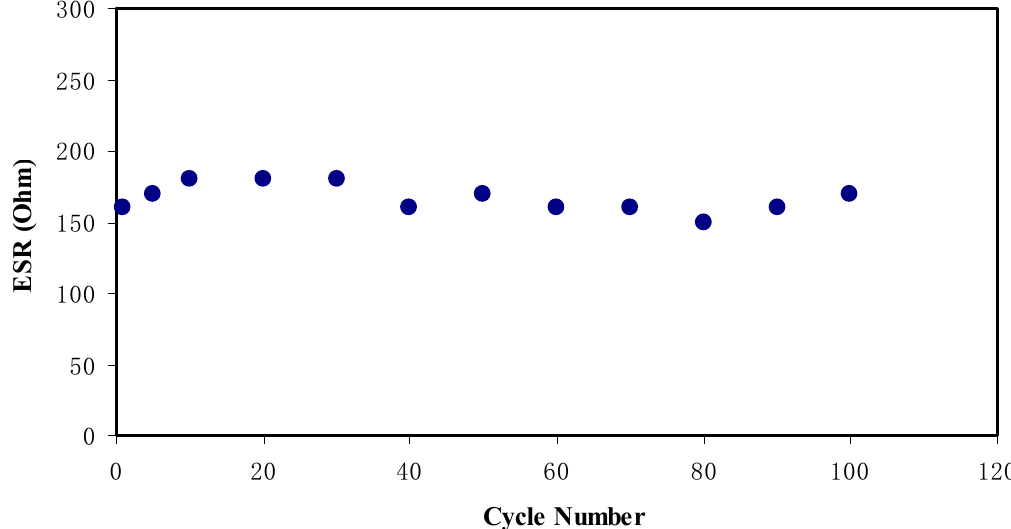
Figure 14. The pattern of equivalent series resistance of the EDLC for 100 cycles.